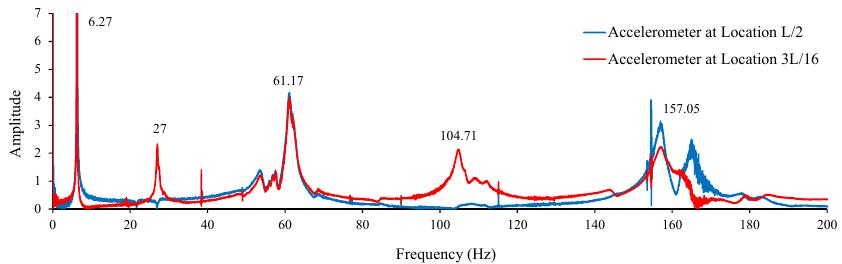
Figure 17. FFT of acceleration responses at locations L/2 and 3L/16.